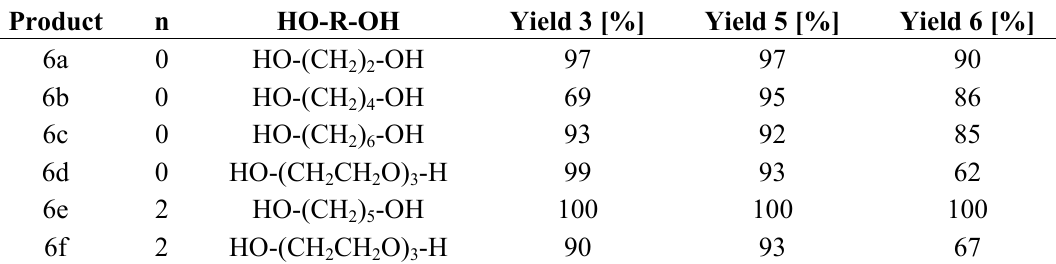
Table 1. Synthesis of bisynones 6